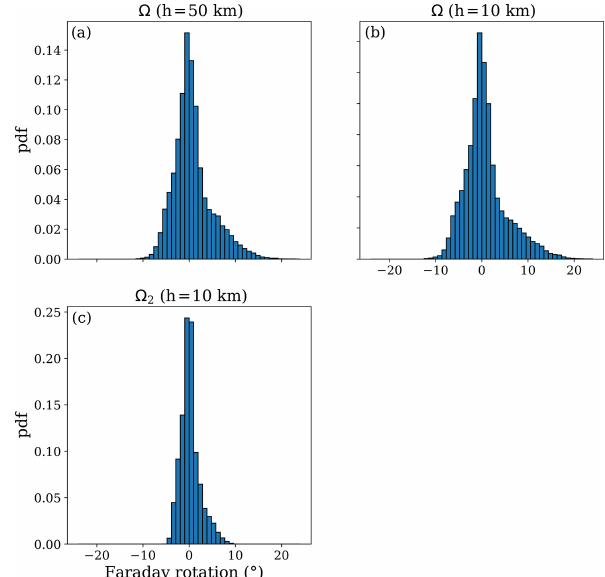
Figure 7. Histograms for the Faraday rotation values. Panels (a) and (b) represent the histograms for the total Faraday rotation ( (cid:127) ) eval- uated at the ray with tangent point’s height around (a) 50km and (b) 10km. In (c) there is the histogram for the second part of the Faraday rotation ( (cid:127) 2 ), evaluated at the ray with tangent point’s height of